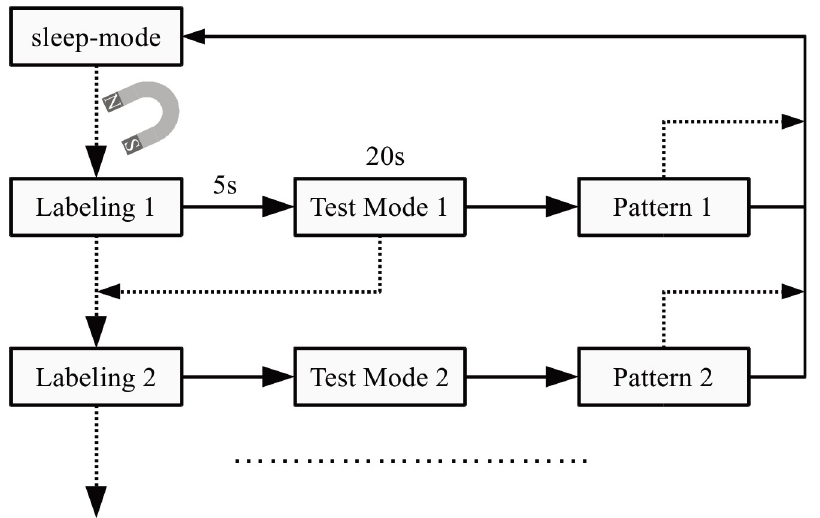
Fig 4. Implementing a labeling sequence followed by a test mode when more than one stimulation pattern is required. The dotted lines represent actions that are triggered, bringing a strong magnet near the implant.